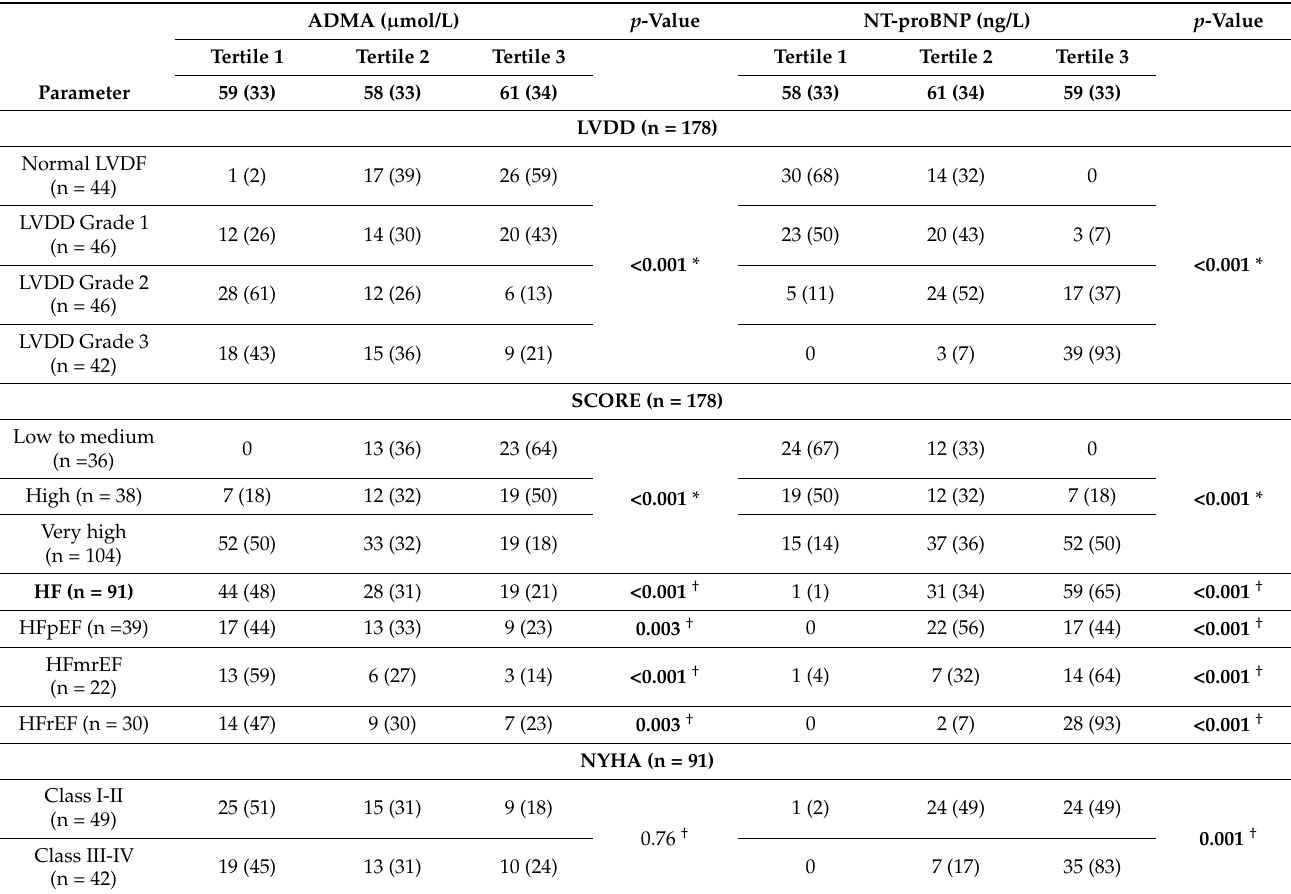
Table 4. Distribution of study subjects depending on LVDD, SCORE2, HF, and NYHA class and tertiles of ADMA and NT-proBNP in plasma. ADMA ( µ mol/L) p -Value NT-proBNP